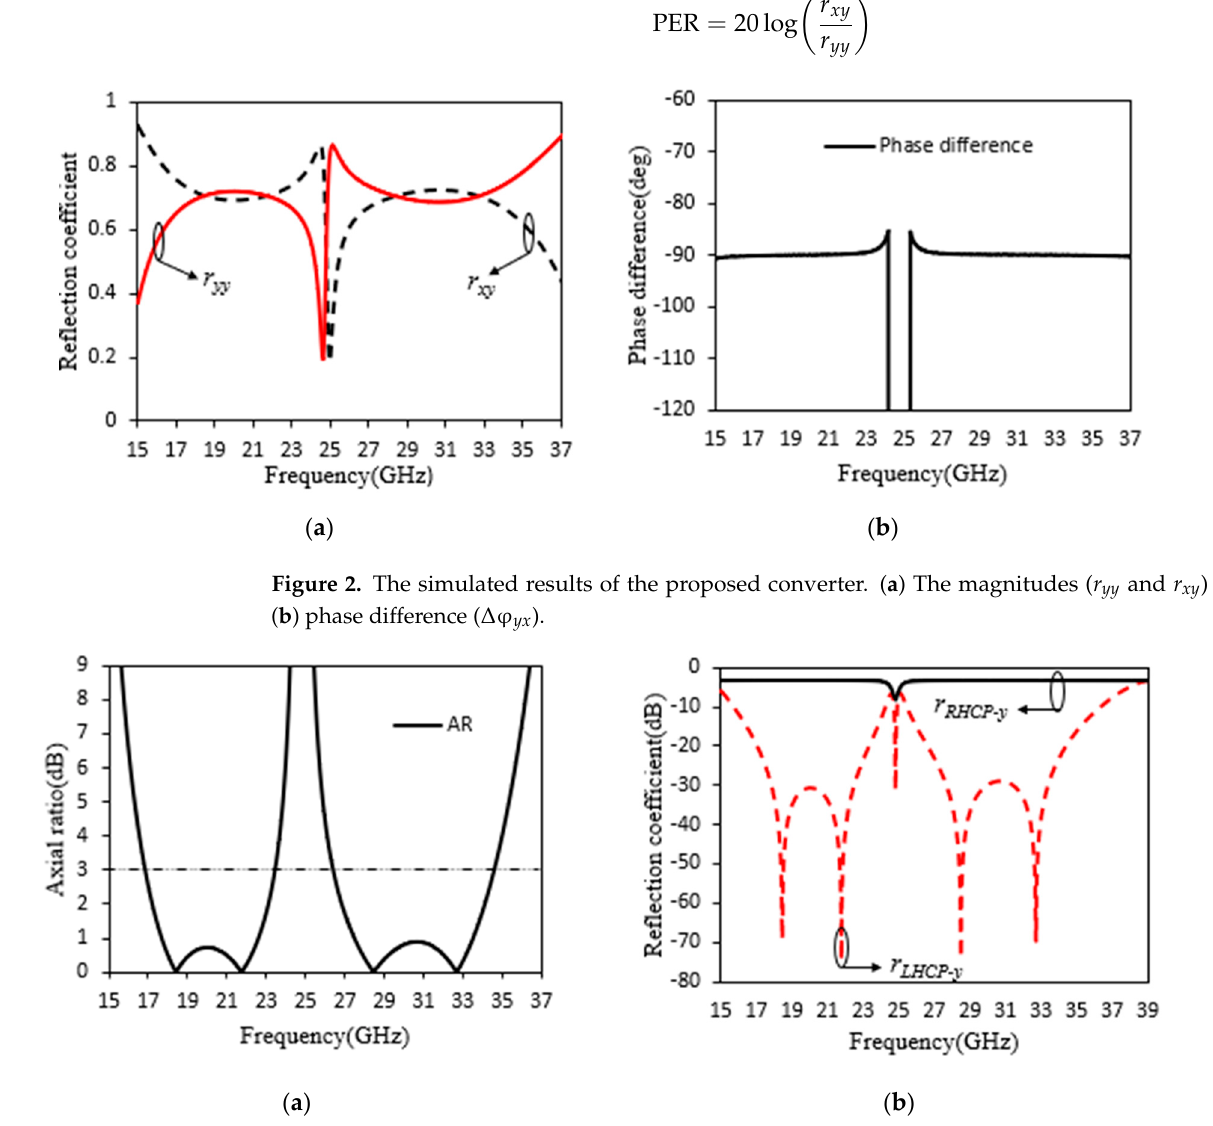
( b ) Figure 4. The calculated results of proposed converter under y -polarized incidence. ( a ) Linear-to- circular polarization conversion ratio (%) and ( b ) polarization extinction ratio (dB). Parameters Analysis The aim of this section is to investigate how different parameters influence the phase difference and 3 dB axial ratio of the dual-frequency wideband linear-to-circular polari- zation conversion. To achieve an optimal parameter, we optimized the values of the radial stub ( r ) and the width of the rectangular patch ( w ). A sequence of parametric simulations was performed to evaluate the influence of the parameters on the phase difference and 3 dB axial ratio of the converter unit cell when one parameter was changed while the other stayed the same. The calculated results of the parametric phase difference and 3 dB axial ratio of the dual-frequency wideband LTC polarization conversion are shown in Figures